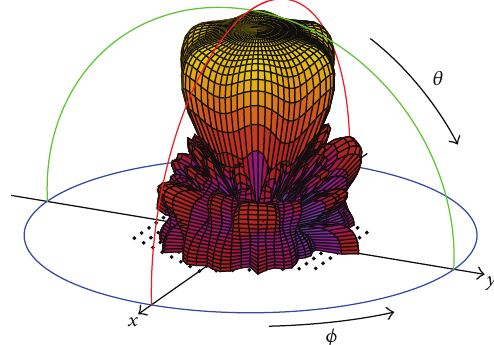
Figure 9: SHA-169 pattern shaped to 𝑆 𝑓 using the collapsed distribution principle.